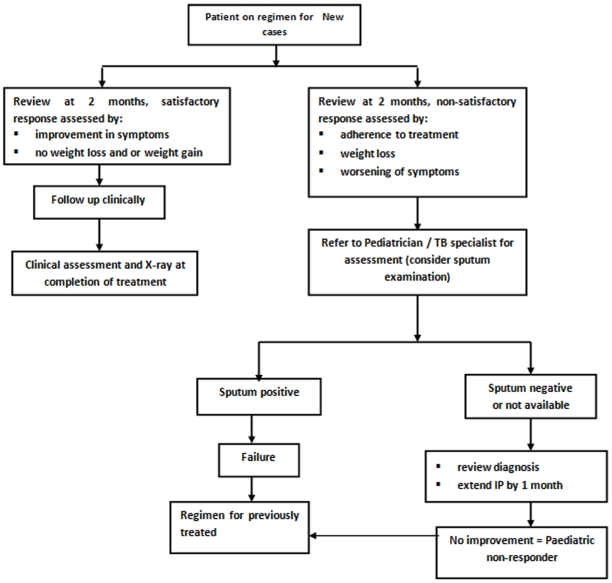
Algorithm for clinical monitoring of childhood TB patients.